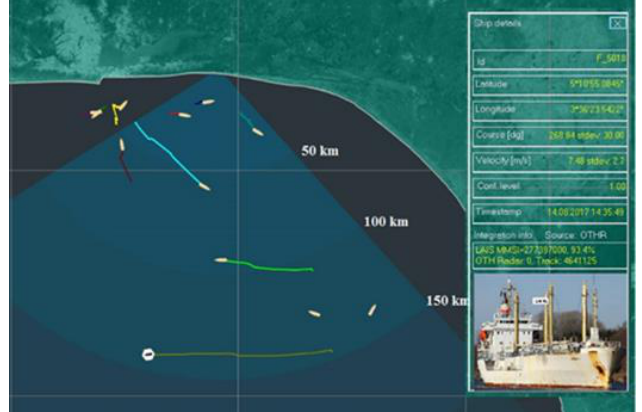
Figure 11. HFSWR detection capabilities during bad weather conditions over part of the HFSWR surveillance.